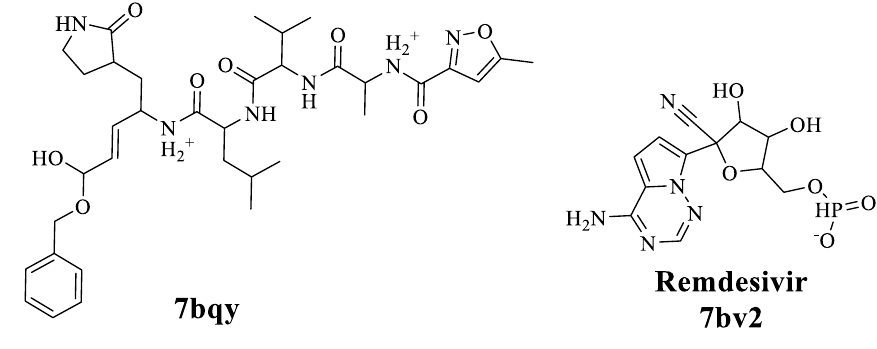
Fig. 3 Structures of the native ligand of the target proteins (PDB ID: 7BQY and